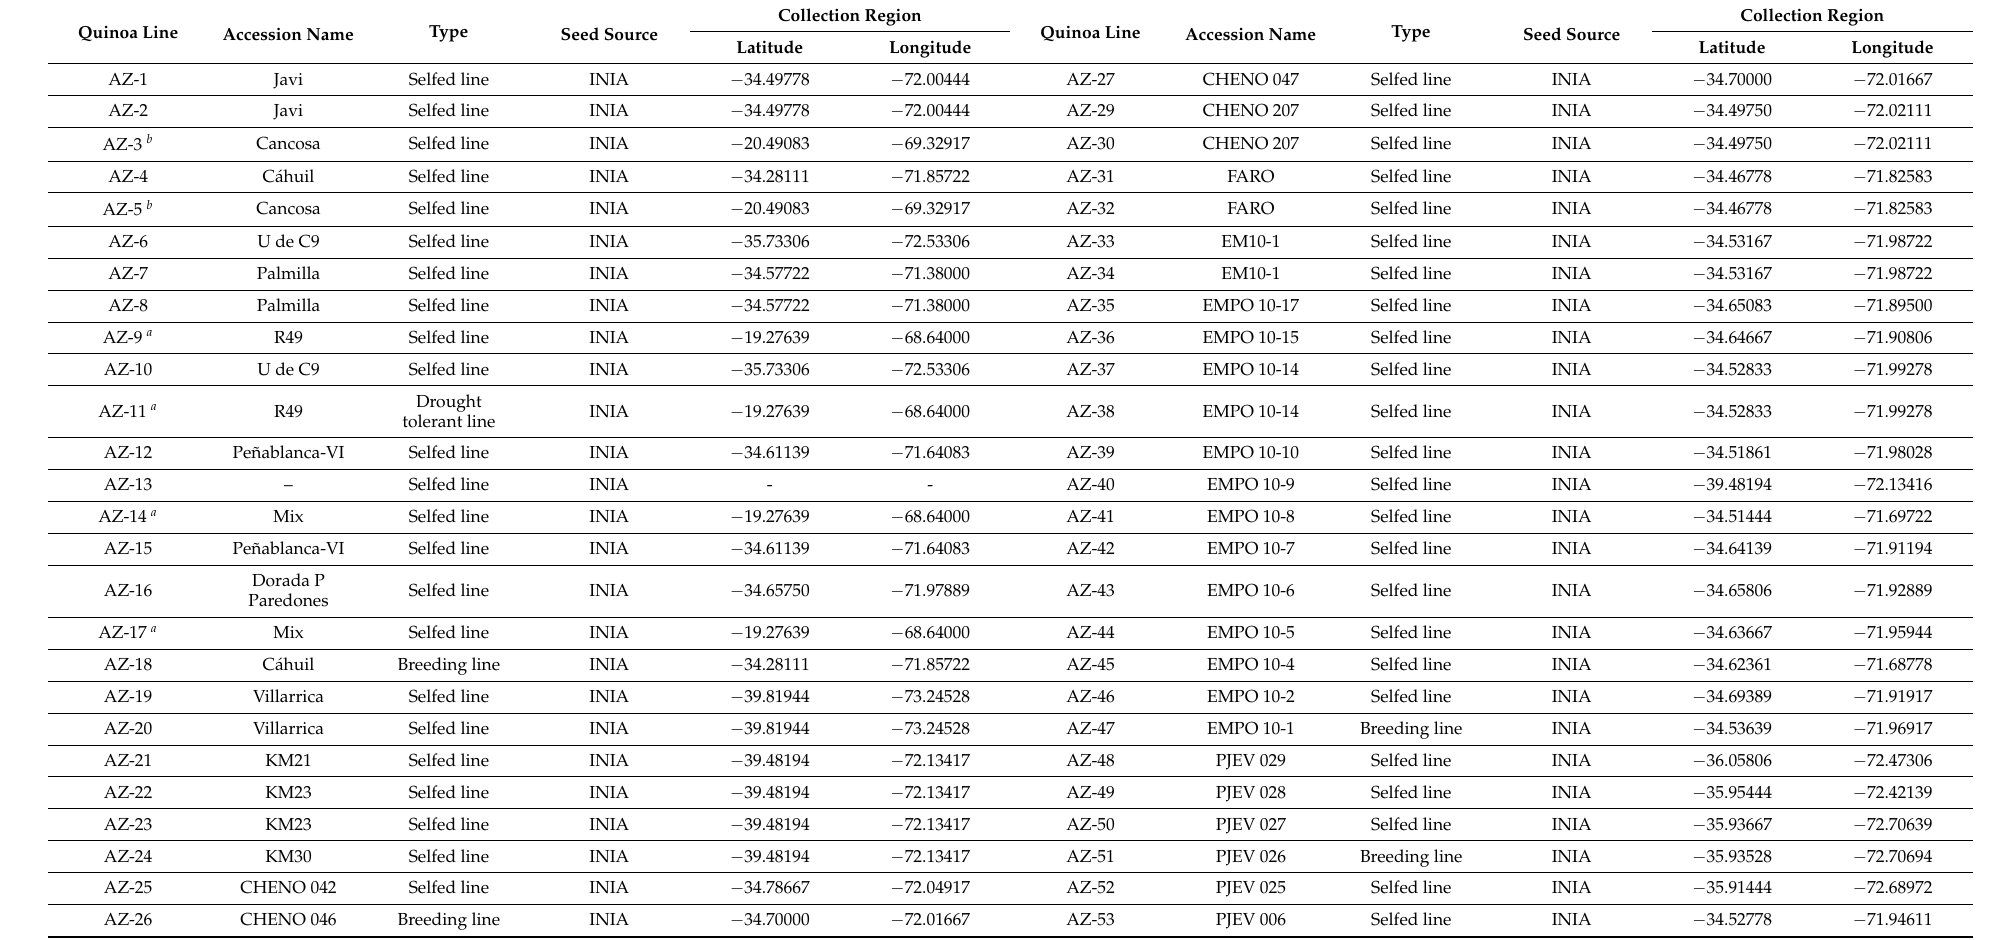
Table 1. Accession name, seed source, and collection region of the C. quinoa lines studied for saponin